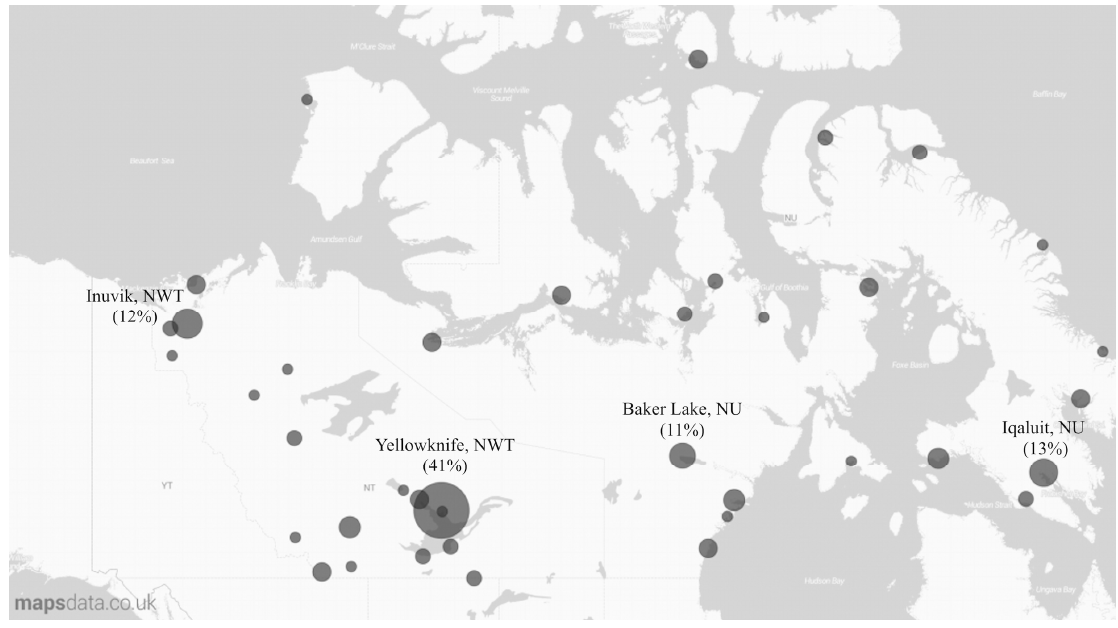
Figure 1. % of territorial events by community of origin.